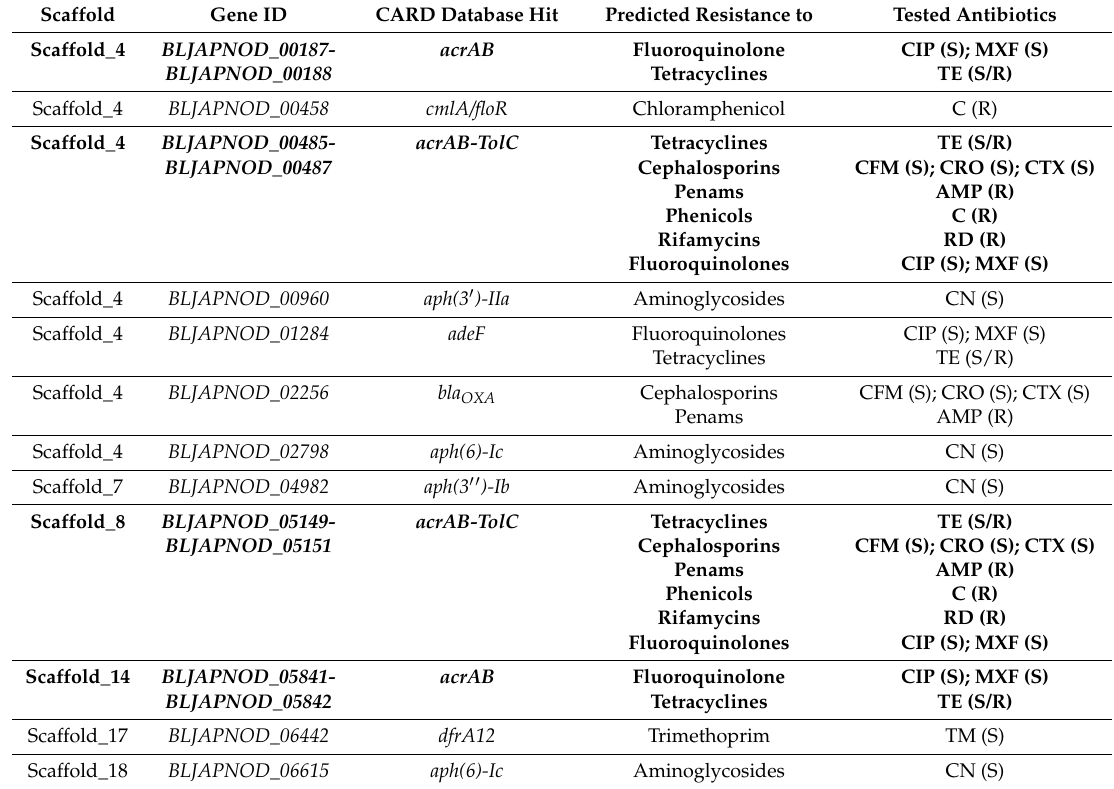
Table 2. Putative antimicrobial resistance genes found in the Ensifer sp. M14 genome. Scaffold Gene